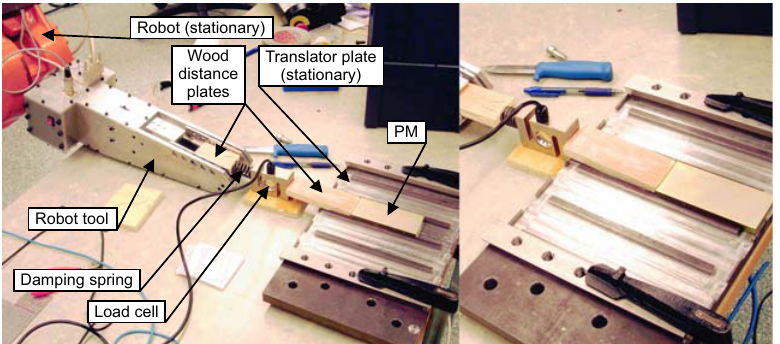
Figure 2. The PM assembly force experimental setup. ( Left ) The PM is being pushed forward; ( Right ) the PM has reached is final position.